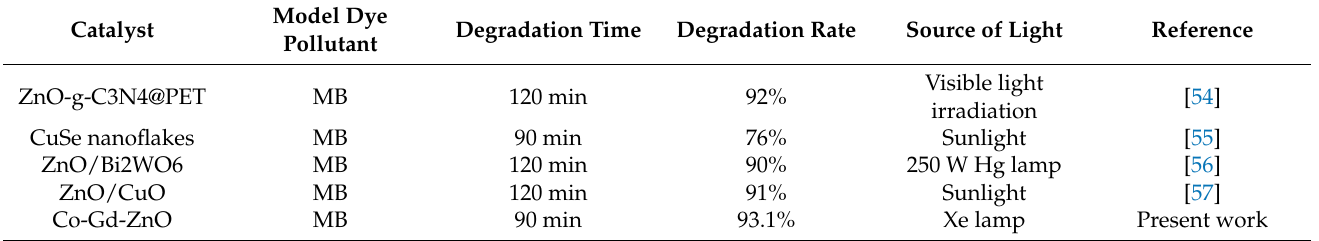
Figure 9. ( a ) Degradation of MB with Co-Gd-ZnO sample as a photocatalyst; ( b ) degradation rate for all the synthesized samples. Table 5. Comparison table for degradation of dye.